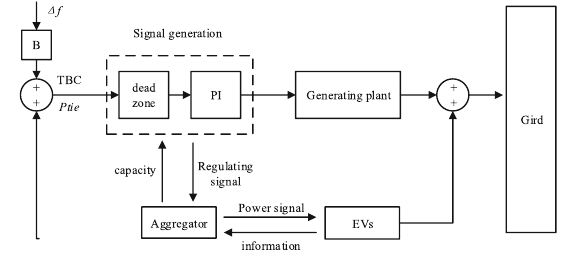
Fig. 2 V2G framework for AGC with